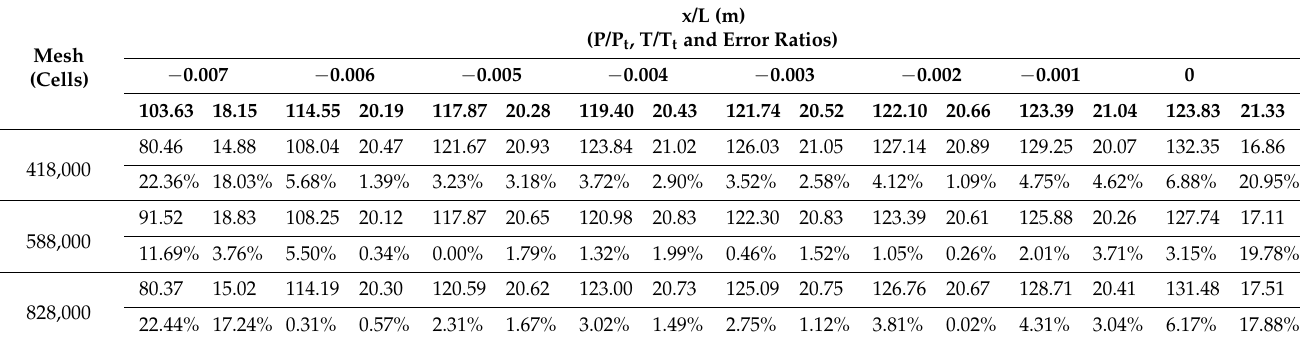
Table 3. Three different level meshes with error ratios at a far-field distance of 20 m for grid